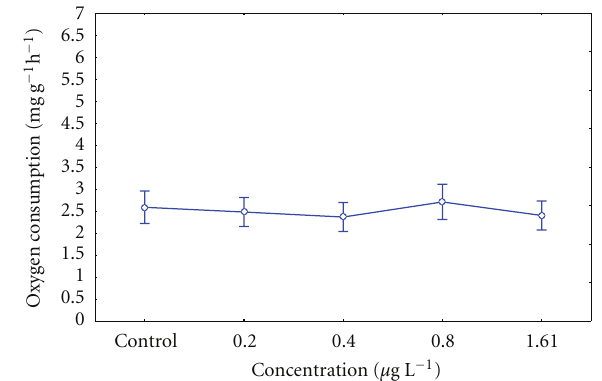
Figure 2: Oxygen uptake of Aulacomya ater in control and exposed grow sublethal concentrations of organophosphate pesticide. Mean values with standard error